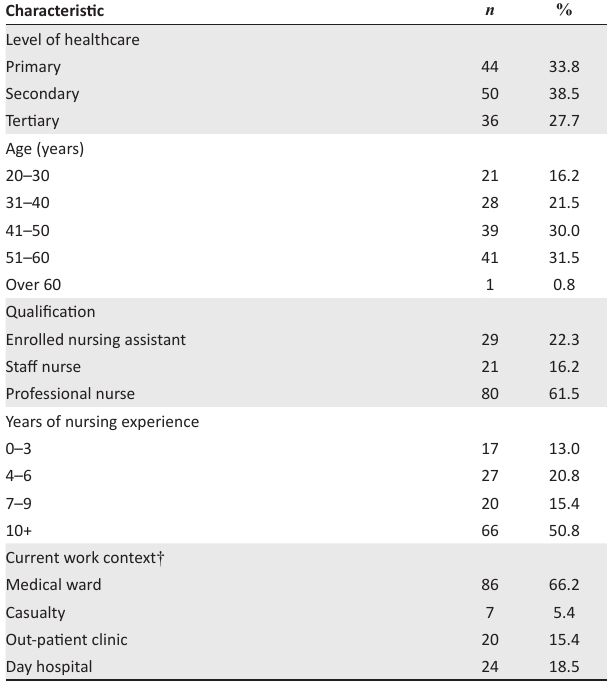
TABLE 1: Participants’ socio-demographic characteristics and professional experience ( N =